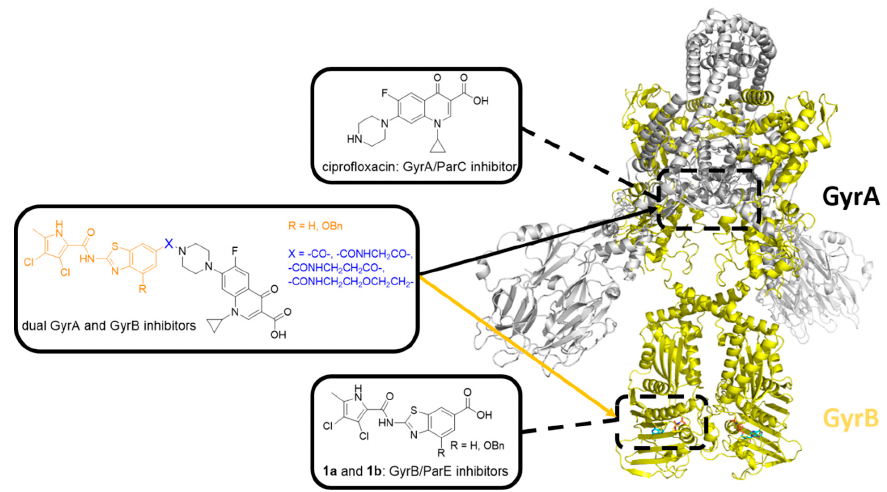
Figure 1. Structure of E. coli DNA gyrase (Protein Data Bank (PDB) entry: 6RKW [23]). The two GyrA subunits are in gray, and the binding site of GyrA/ParC inhibitor ciprofloxacin is represented by the upper black dashed rectangle. The two GyrB subunits are in yellow, and the binding site of GyrB/ParE inhibitors 1a and 1b is represented by the lower black dashed rectangle. The general structure of GyrA/ParC and GyrB/ParE inhibitor hybrids is shown in the middle.